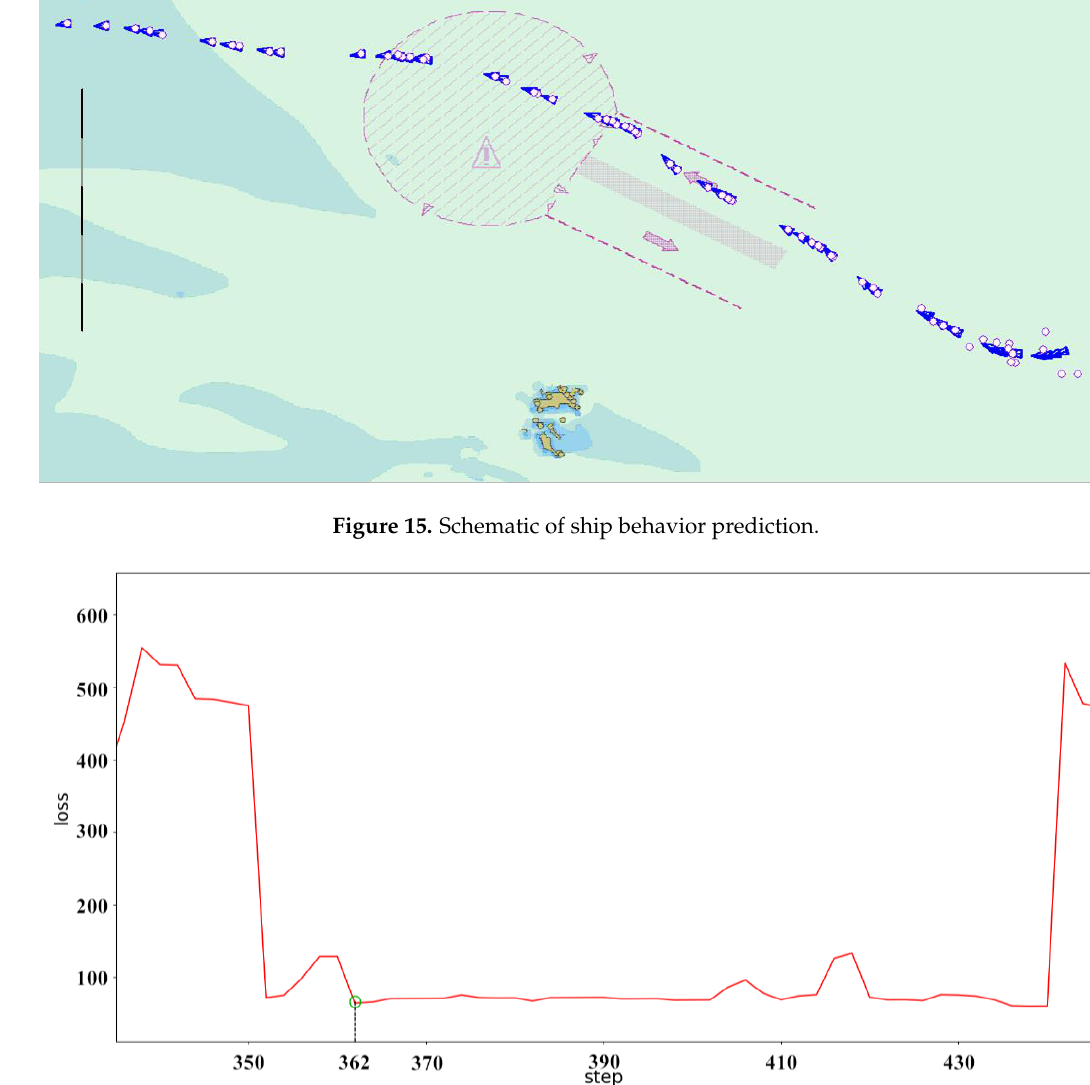
Figure 16. Single-ship prediction error diagram for verification group.